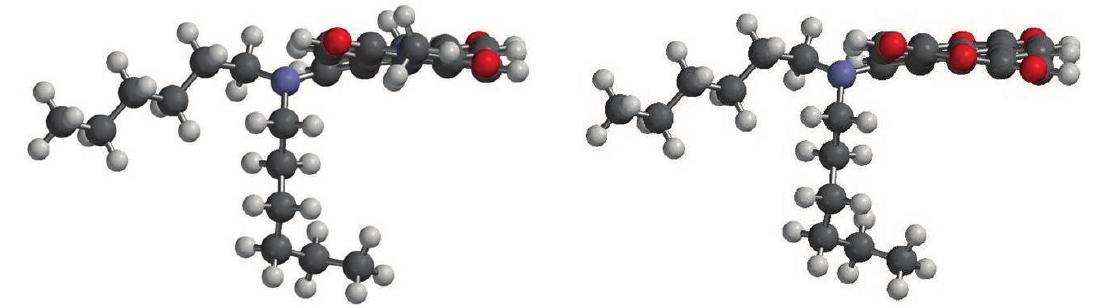
Figure 8. DFT (B3LYP/6-31G**) geometry-optimized structures of 1a ( right ) and 2a ( left ) shown with the view along the long perylene axis. For computational purposes, methyl groups replace the cyclohexyl groups at the imide